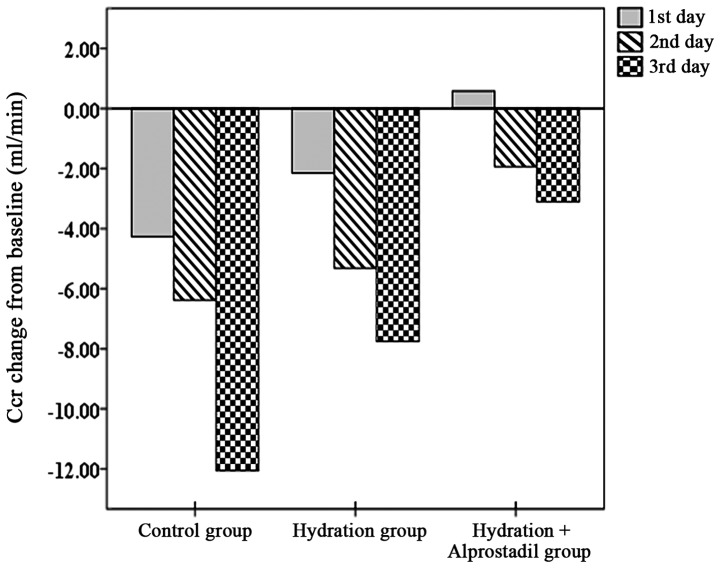
Mean change in Ccr value from baseline following PCI. ① Control group; ① hydration group; ③ hydration + alprostadil group. Day 1 after PCI: ① vs. ② and ② vs. ③, P>0.05; ① vs. ③, P<0.05. Day 2 after PCI: ① vs. ② and ② vs. ③, P>0.05; ① vs. ③, P<0.05. Day 3 after PCI: ① vs. ②, P<0.05; ① vs. ③ and ② vs. ③, P<0.01. Ccr, creatinine clearance; PCI, percutaneous coronary intervention.